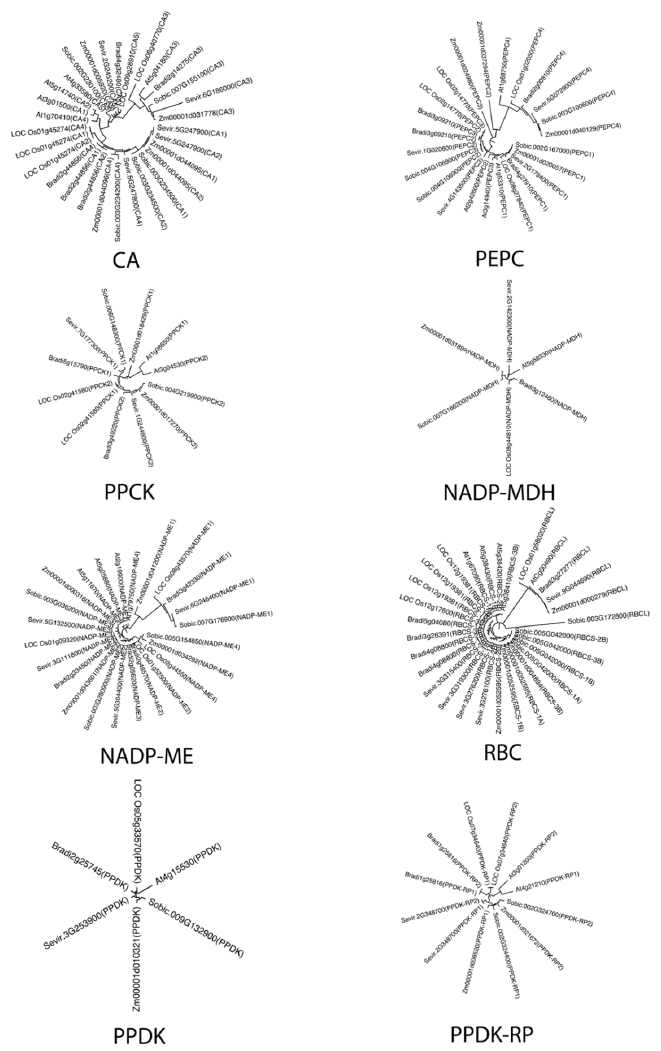
Figure 2. Phylogenetic trees of key enzymes in the carbon-delivery chain of C4 NADP-ME photo- synthesis. Trees are arranged by the carbon transformation flow order among these enzymes. All identified paralogs and orthologs were recruited to plot the trees.